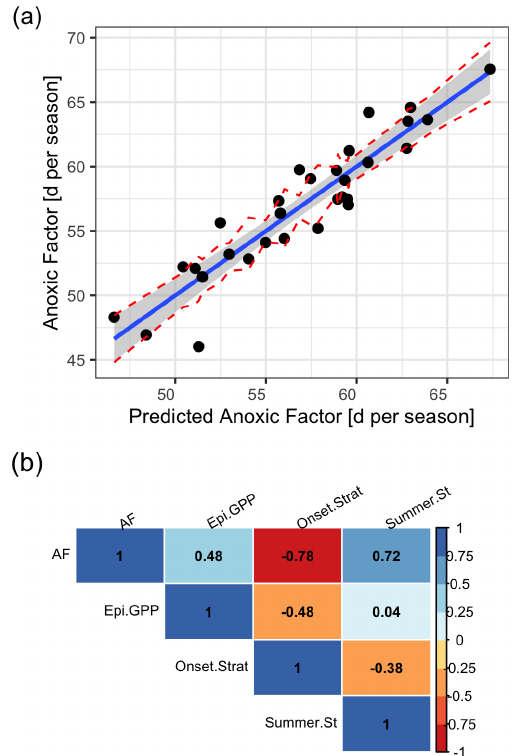
Figure 11. Predicted against simulated summer anoxic fac- tor. (a) Linear model with a prediction that was done us- ing a multiple linear regression model of the form ˆ y = 0 . 24Epi . GPP + 0 . 54Summer . St − 0 . 46Onset . Strat − 5 . 44 × 10 − 17 +ˆ (cid:15) , where ˆ (cid:15)N( 0 , 38 2 ) . The red lines represent confidence intervals. (b) Correlogram of the input data using Pearson correlation coef- ficients. (AF = anoxic factor; Epi.GPP = gross primary production in the epilimnion prior to summer season; Summer.St = summer Schmidt stability; Onset.Strat = day of the year of summer strati- fication